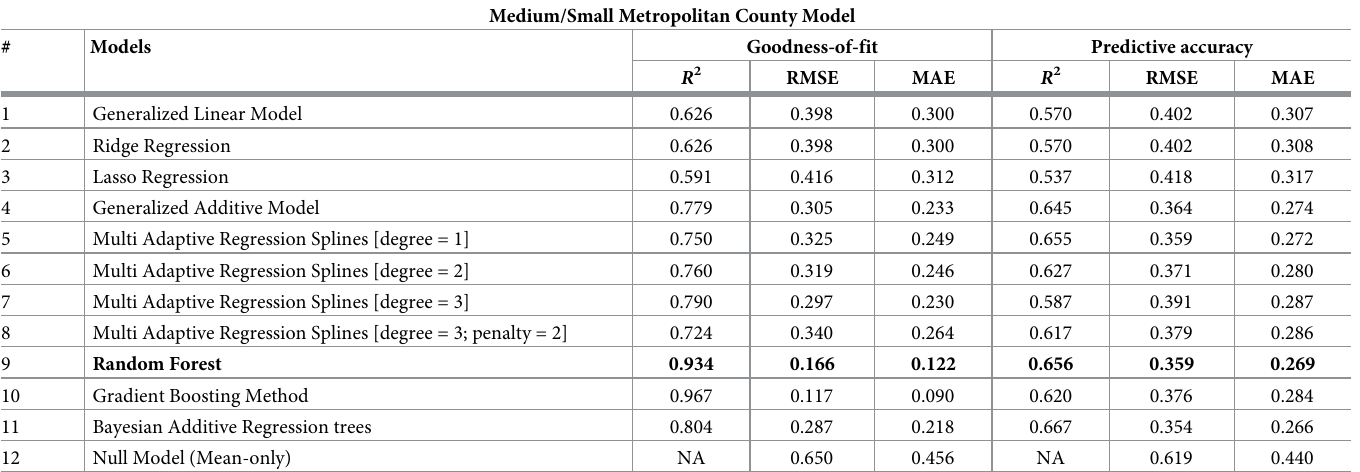
Table 4. Medium/Small metropolitan counties: Model performance